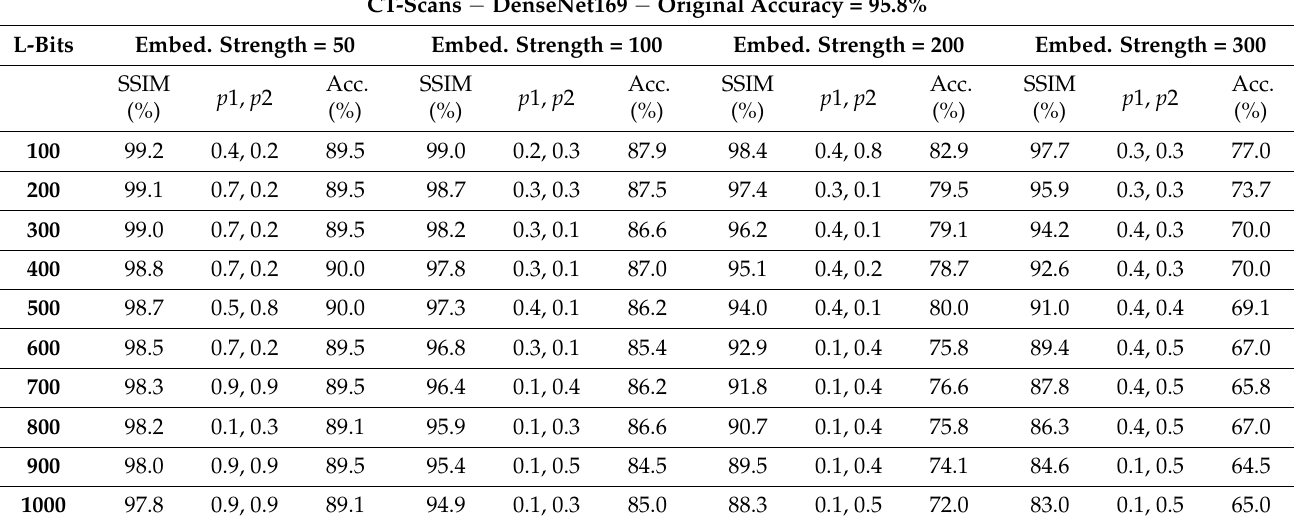
Table A6. KMsWA 2 attacks on DenseNet169 in CT-Scans.